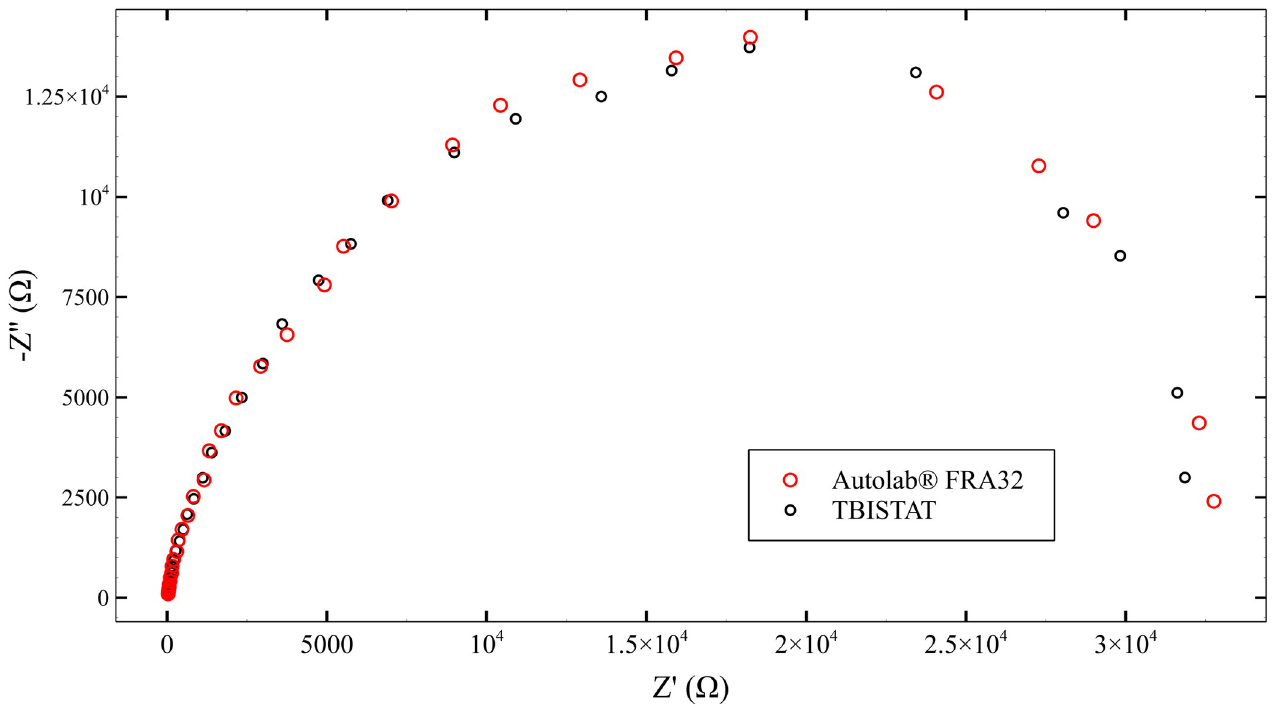
Fig 9. Nyquist plot comparisons of TBISTAT and reference instrument in detecting S100B in an ANTI-S100B functionalized thin-film AUIDEs exposed to 316 pg/ml of S100B spiked human plasma sample.